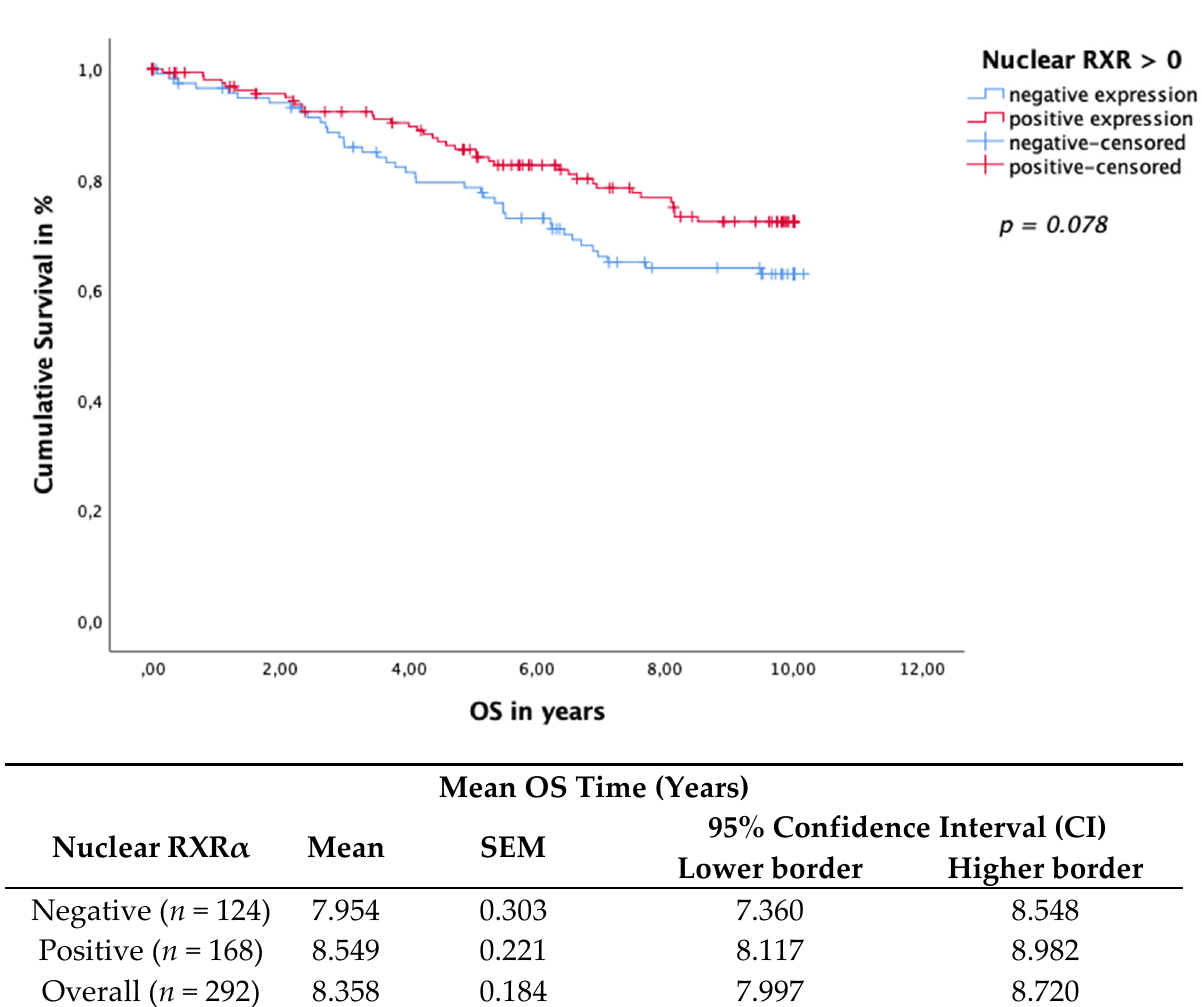
Figure 3. Kaplan–Meier survival analysis of nuclear RXR α positive and negative expression in relation to OS. The risk table demonstrates the mean survival time, SEM and 95% confidence interval (CI) for univariate analyses. Table 3. Multivariate Cox regression analysis of nuclear RXR α expression in relation to OS.